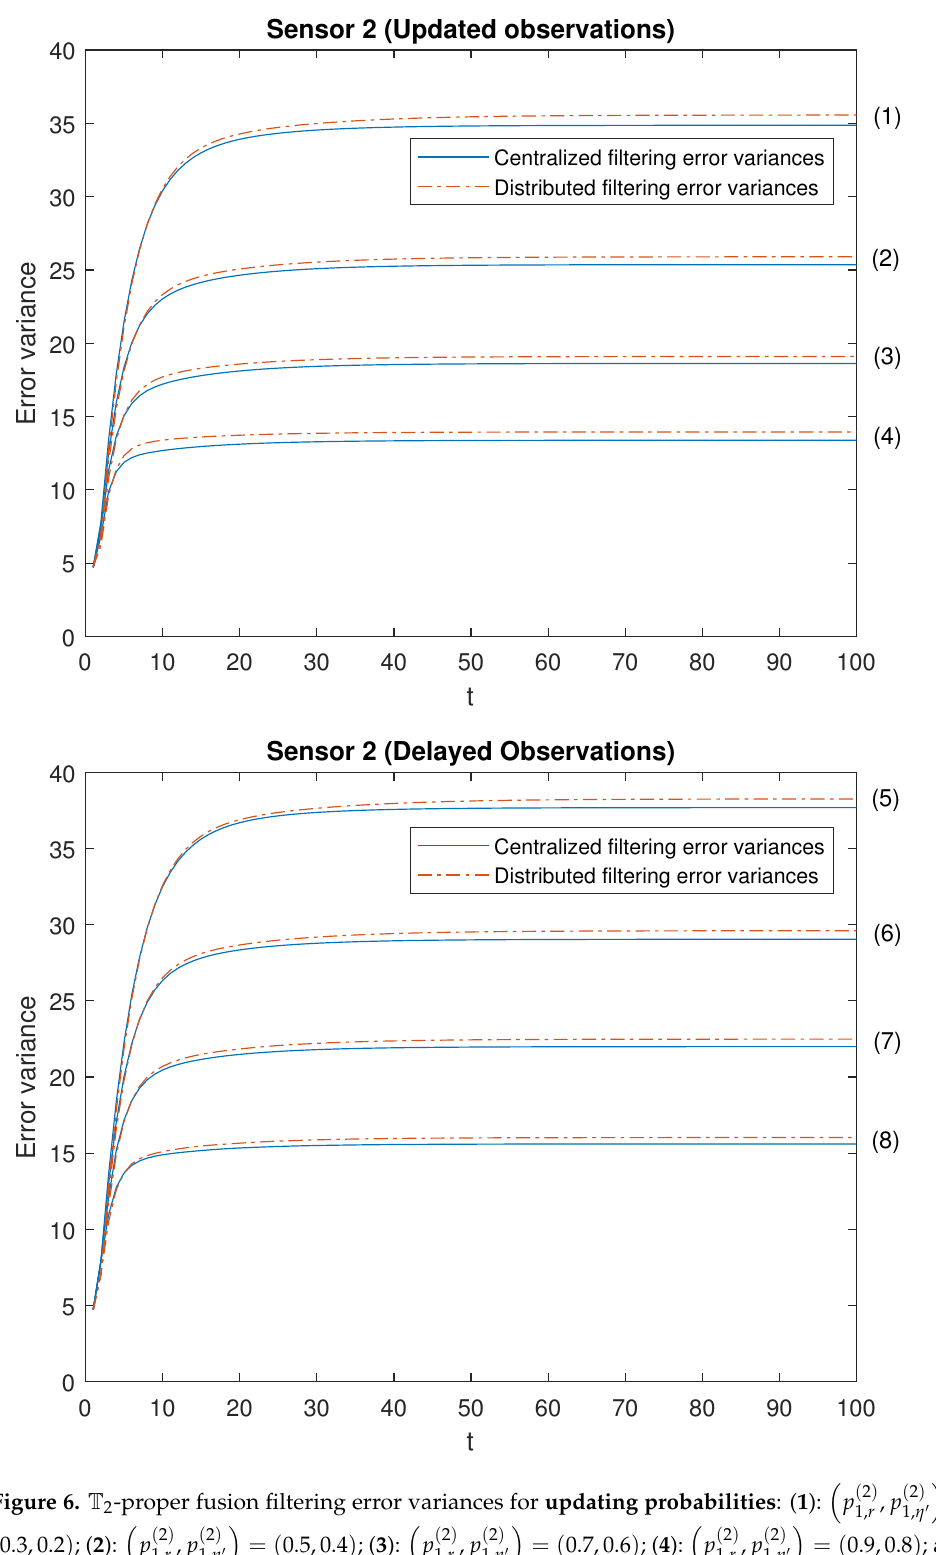
Figure 6. T 2 -proper fusion filtering error variances for updating probabilities : ( 1 ): ( 0.3,0.2 ) ; ( 2 ): delay probabilities : ( 5 ): ( 0.7,0.6 ) ; ( 8 ):